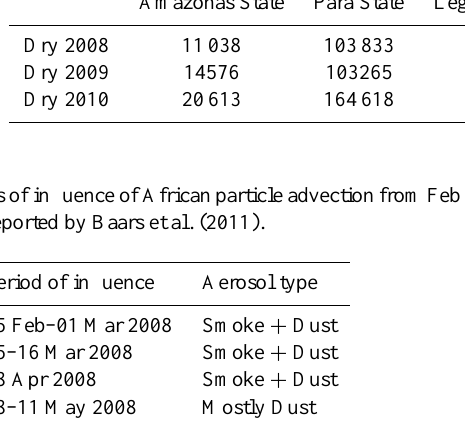
Table 3. Fire spots detected during the dry season (Jul-Dec) in the Amazonas State, Par´a State, Legal Amazonia area, forest reserve neighbor municipalities (Manaus, Rio Preto da Eva, Presidente Figueiredo, Novo Air˜ao), and municipalities eastern to the forest reserve in the State of Amazonas (Barreirinha, Itapiranga, Manaus, Nhamund´a, Parintins, S˜ao Sebasti˜ao do Uatum˜a, Silves and Urucar´a). Source: CPTEC/INPE. Legal Amazonia